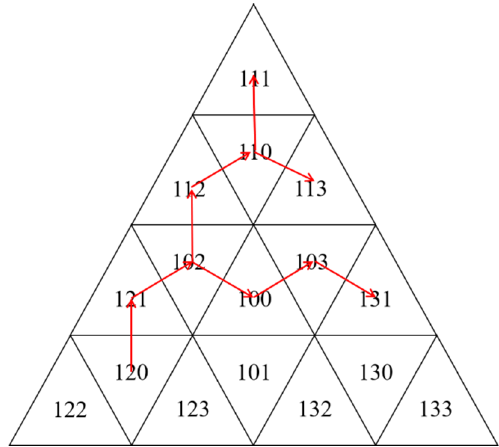
Figure 3. Edge neighbor expansion in the